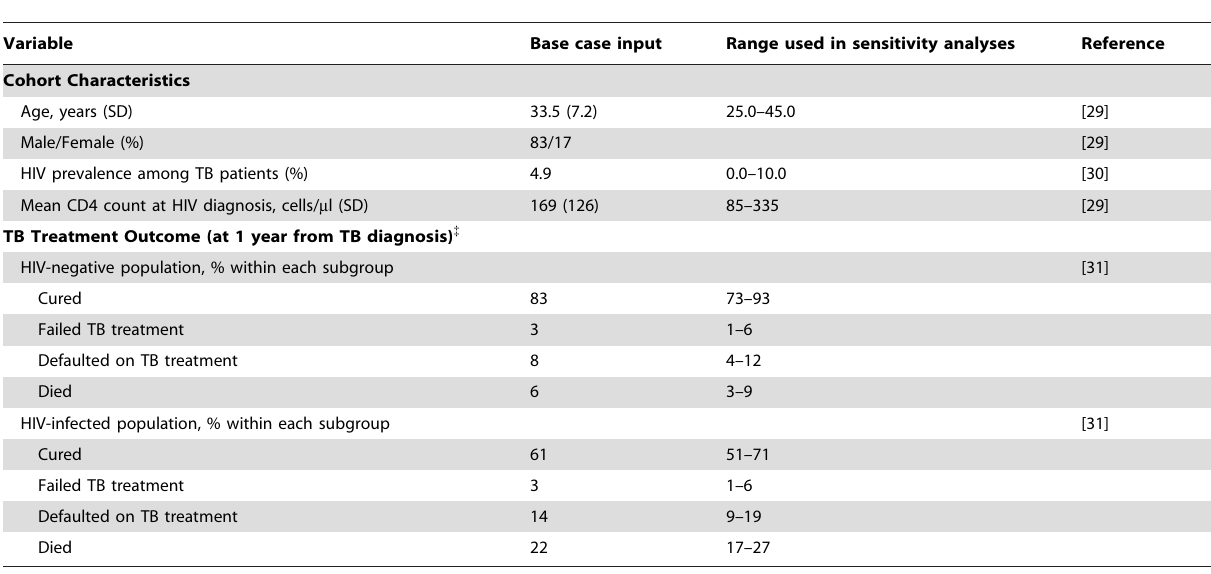
Table 1. Baseline cohort characteristics, TB treatment outcomes, and model inputs for an analysis of HIV testing for TB patients in India.